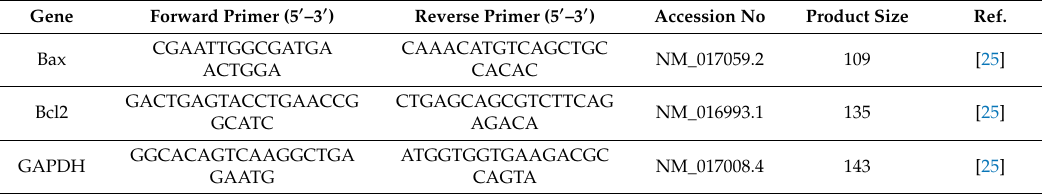
Table 1. Oligonucleotide sequences for interest and reference genes.